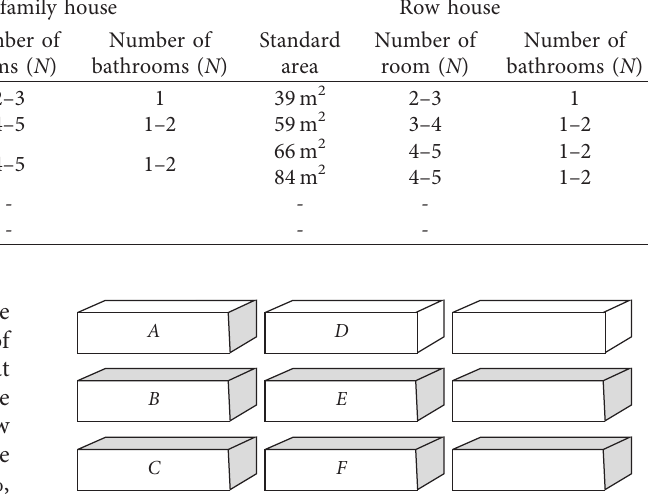
Table 6: Derivation of standard area within area range (Ministry of Land, Infrastructure, and Transport, Korea). Detached house Multifamily house Row house